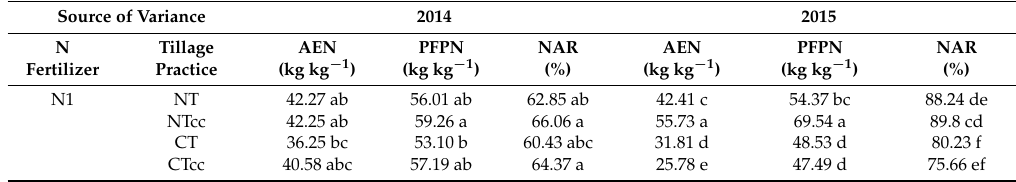
Table 2. Impact of tillage practices and nitrogen fertilization on NUE indices.